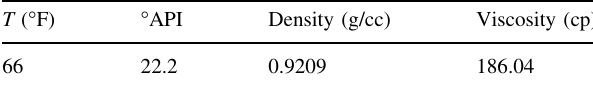
Fig. 2 TEM image of silica nanoparticles used